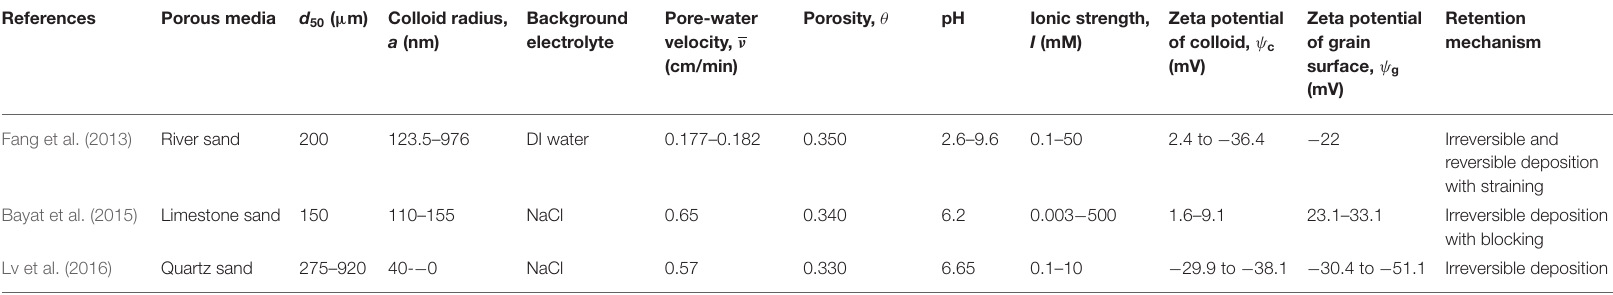
TABLE 5 | Experimental conditions in papers selected to analyse deposition of TiO 2 NPs.